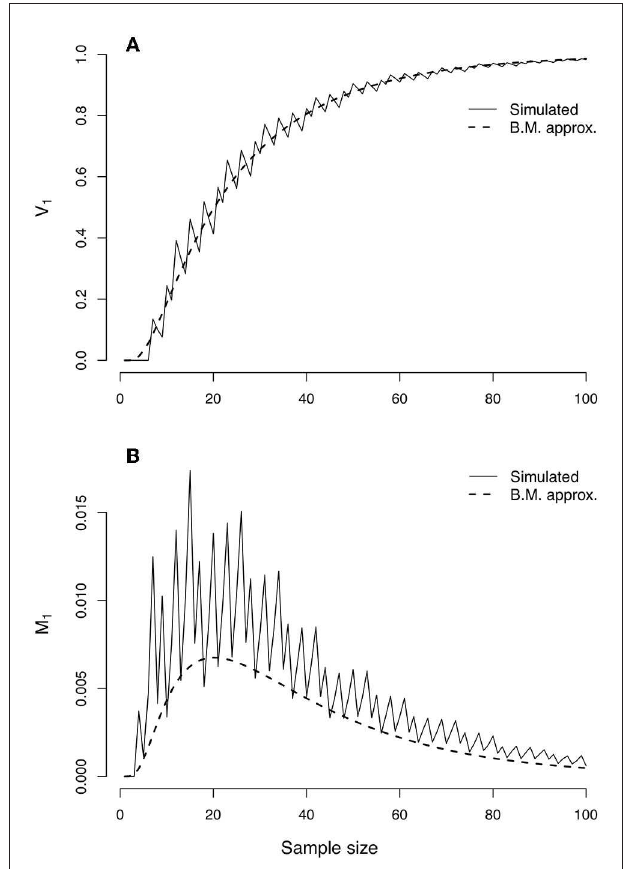
FIGURE 3 | Evidence error probabilities for comparing two Bernoulli( p ) distributions, with p 1 0.75 and p 2 0.50. (A) Simulated values (jagged = = curve) and values approximated under the Central Limit Theorem of the M 1 W 1 . (B) Simulated probability of strong evidence for model H 1 , V 1 1 = − − values (jagged curve) and approximated values for the probability of misleading evidence M 1 . Note that the scale of the bottom graph is one fifth of that of the top